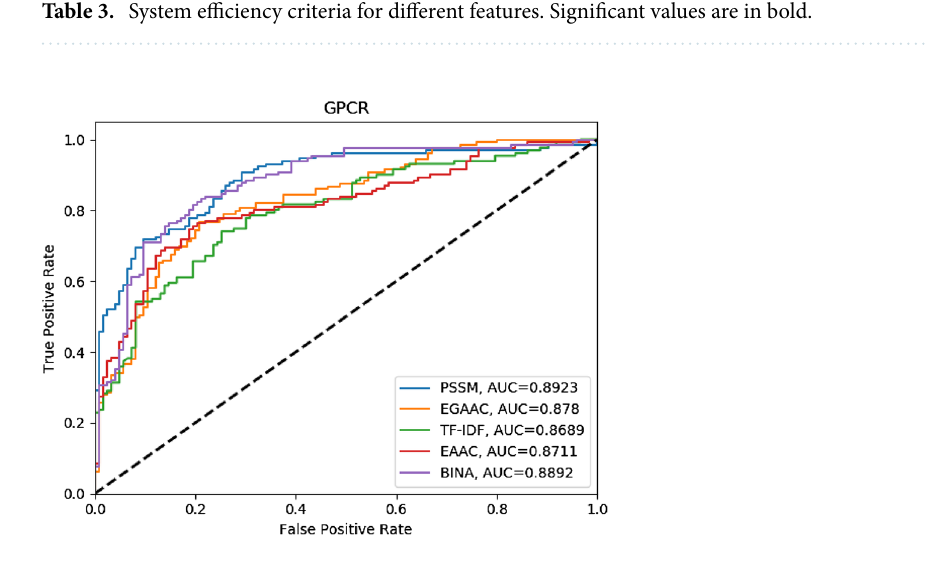
Figure 4. ROC diagram for the comparison of the five